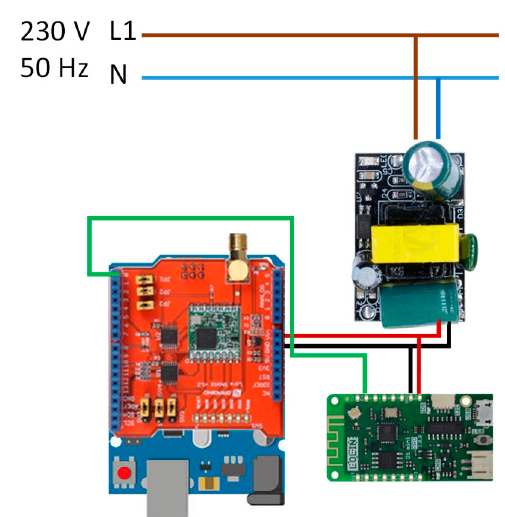
Figure 3. Wiring diagram of GWLN. Table 3. GWLN components cost.